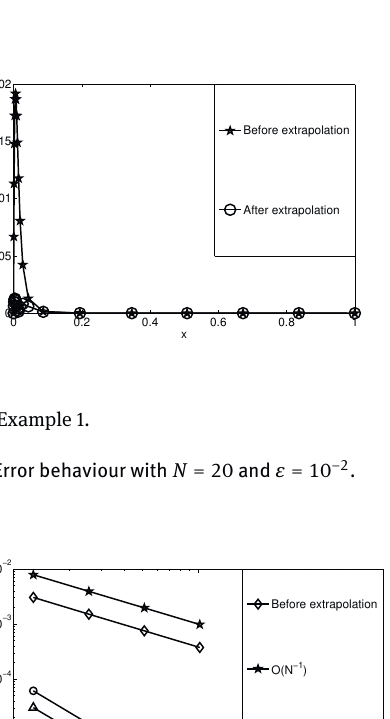
Fig. 1: Numerical solution with N = 40 and ε = 2 −8 .